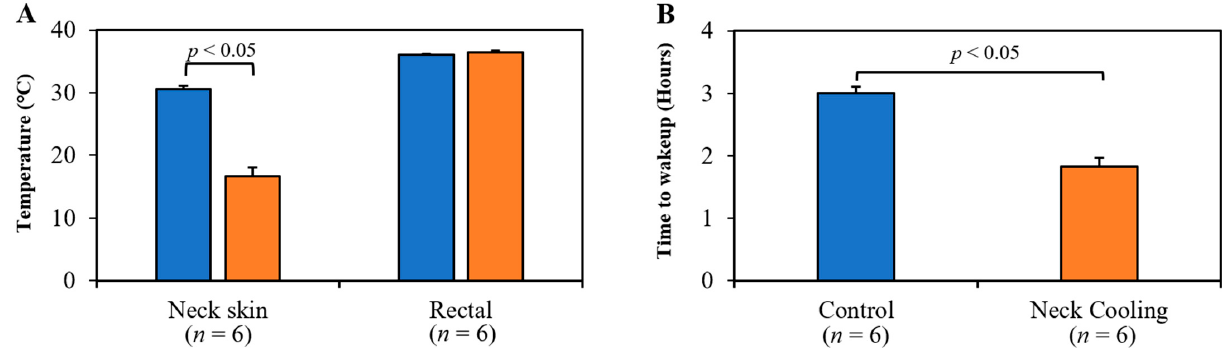
Figure 3. ( A ) Topical neck cooling lowered the neck skin temperature to 17 °C ( p < 0.05 vs. control at 31 °C, left panel) without lowering rectal temperature. ( B ) Rats emerged from anesthesia significantly earlier after treatment with neck cooling.